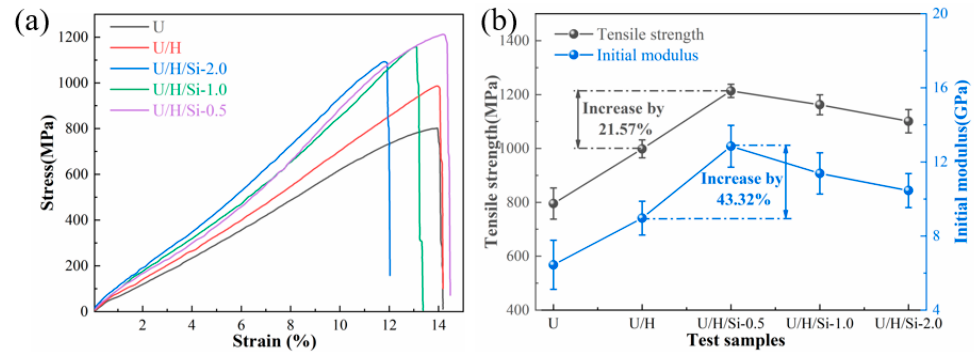
Figure 9. ( a ) Stress-strain curves of all fiber samples; ( b ) tensile strength and initial modulus for all fiber samples. fiber